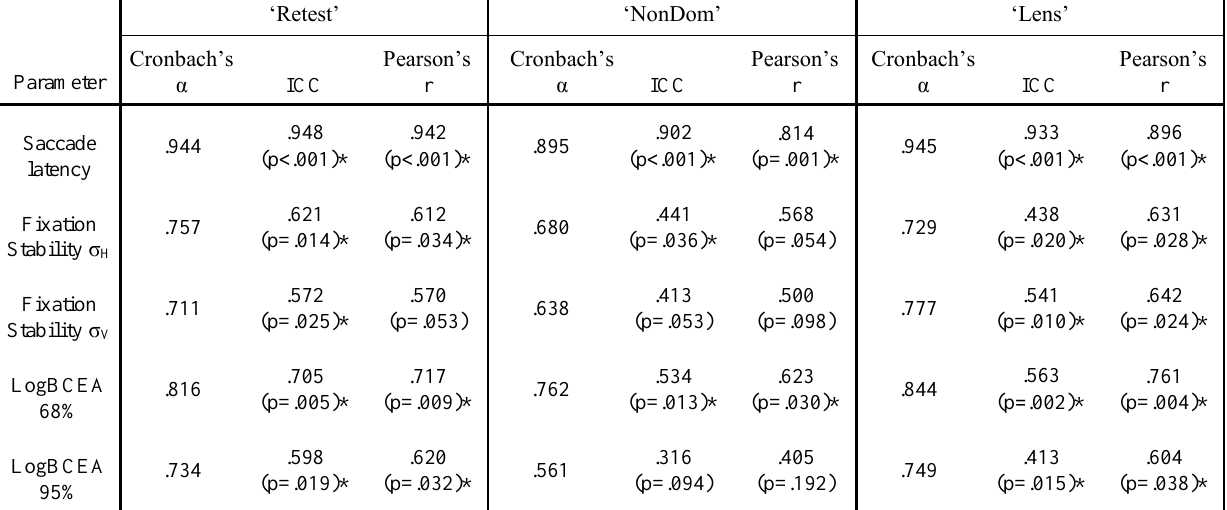
Cronbach’s α, Intraclass Correlation Coefficient and Pearson’s r for eye movement parameters across conditions. * indicates p < .05